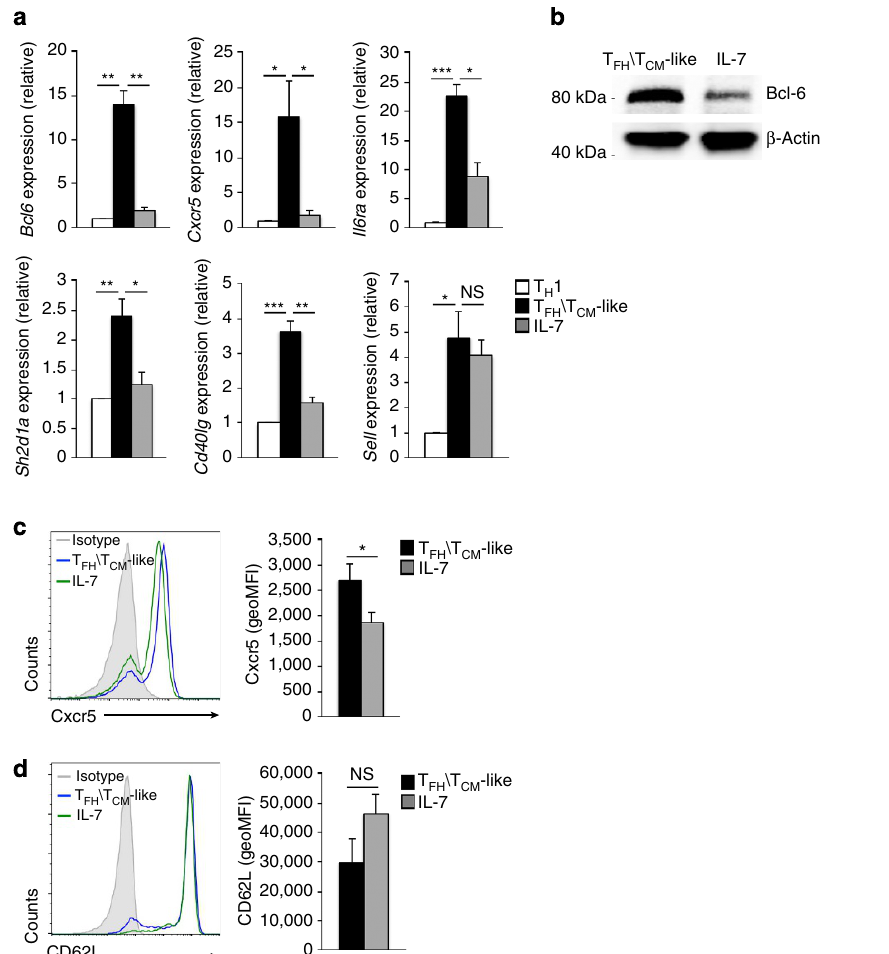
Figure 5 | IL-7 signalling represses Bcl-6 and T FH gene expression patterns. Primary CD4 þ Tcells were cultured in T H 1 conditions and exposed to either high or low environmental IL-2 to generate effector T H 1 or T FH /T CM -like (IL-6R a þ IL-7R þ ) cells, respectively. T FH /T CM -like cells were then exposed to IL-7. Following a 24 or 48h incubation, expression of the indicated genes was measured by ( a ) qRT–PCR, ( b ) immunoblot or ( c , d ) flow cytometric analysis. For a , the sample values are presented as fold change in expression relative to the T H 1 sample for each independent experiment (mean of n ¼ 3 ± s.e.m.). For b , Bcl-6 protein was measured with b -actin serving as a loading control. Shown is a representative blot of three independent experiments performed. For c and d , data are represented either as histogram flow cytometry plots or quantified geometric mean fluorescence intensity (geoMFI; mean of n ¼ 5 ±